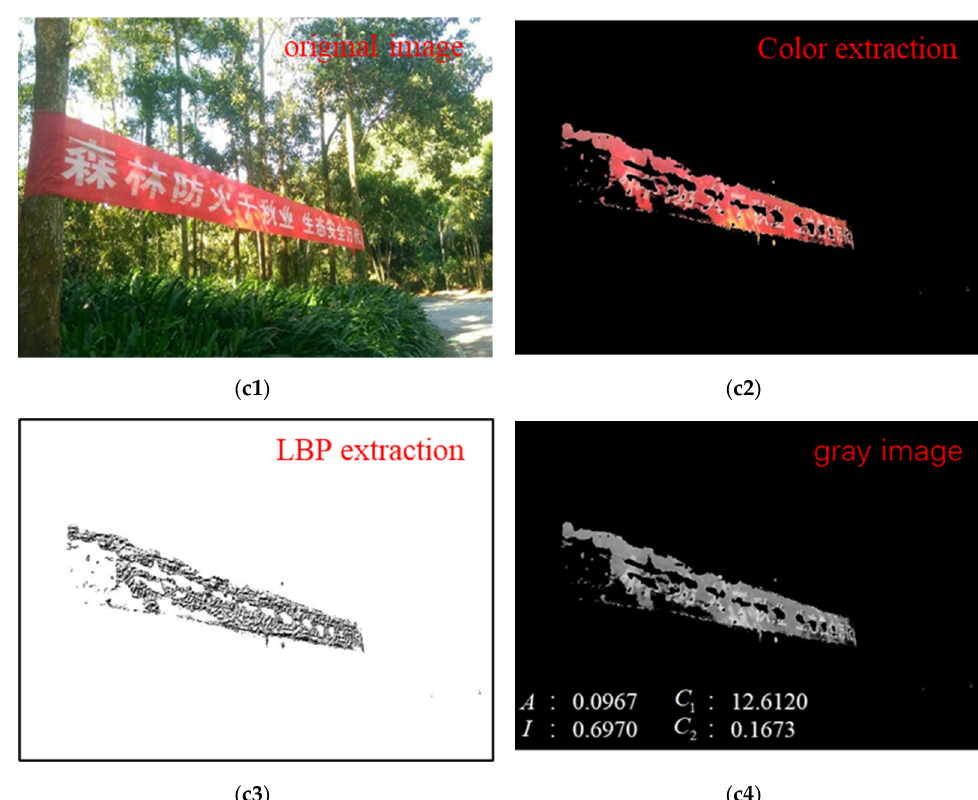
Figure 10. Experimental image sample and extraction results: ( a1 ) forest image without fire; ( a2 ) color extraction result of forest image without fire; ( a3 ) LBP extraction result of forest image without fire; ( a4 ) gray image of forest image without fire; ( b1 ) forest image with fire; ( b2 ) color extraction result of forest image with fire; ( b3 ) LBP extraction result of forest image with fire; ( b4 ) gray image of forest image with fire; ( c1 ) forest image with fire-like interference; ( c2 ) color extraction result of forest image with fire-like interference; ( c3 ) LBP extraction result of forest image with fire-like interference; ( c4 ) gray image of forest image with fire-like interference.